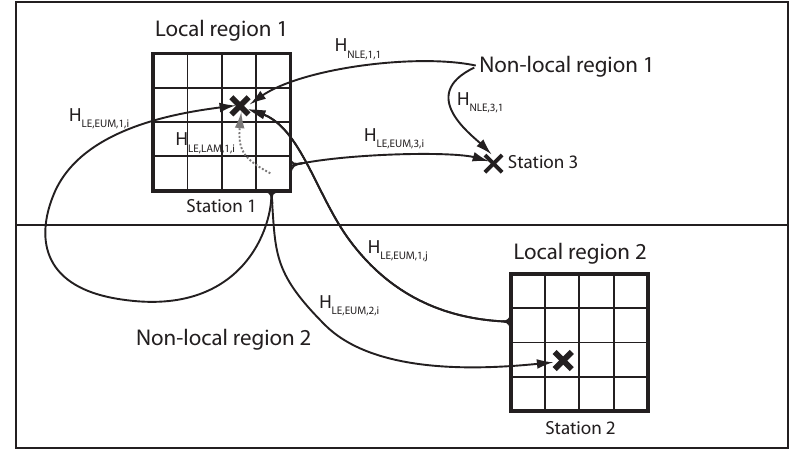
Fig. 1. A schematic of emissions regions and sensitivities. Two large “non-local” regions are shown from which bulk emissions are estimated, and two “local” regions close to monitoring sites, within which small-scale emissions can be estimated. The arrows show examples of the sensitivity components, with each arrow originating from an emissions element (cell i in local region 1 and j in local region 2) and ending at a measurement site. The grey dashed arrow indicates the sensitivity component calculated by the LPDM and the solid black arrows show the sensitivity components calculated by the Eulerian